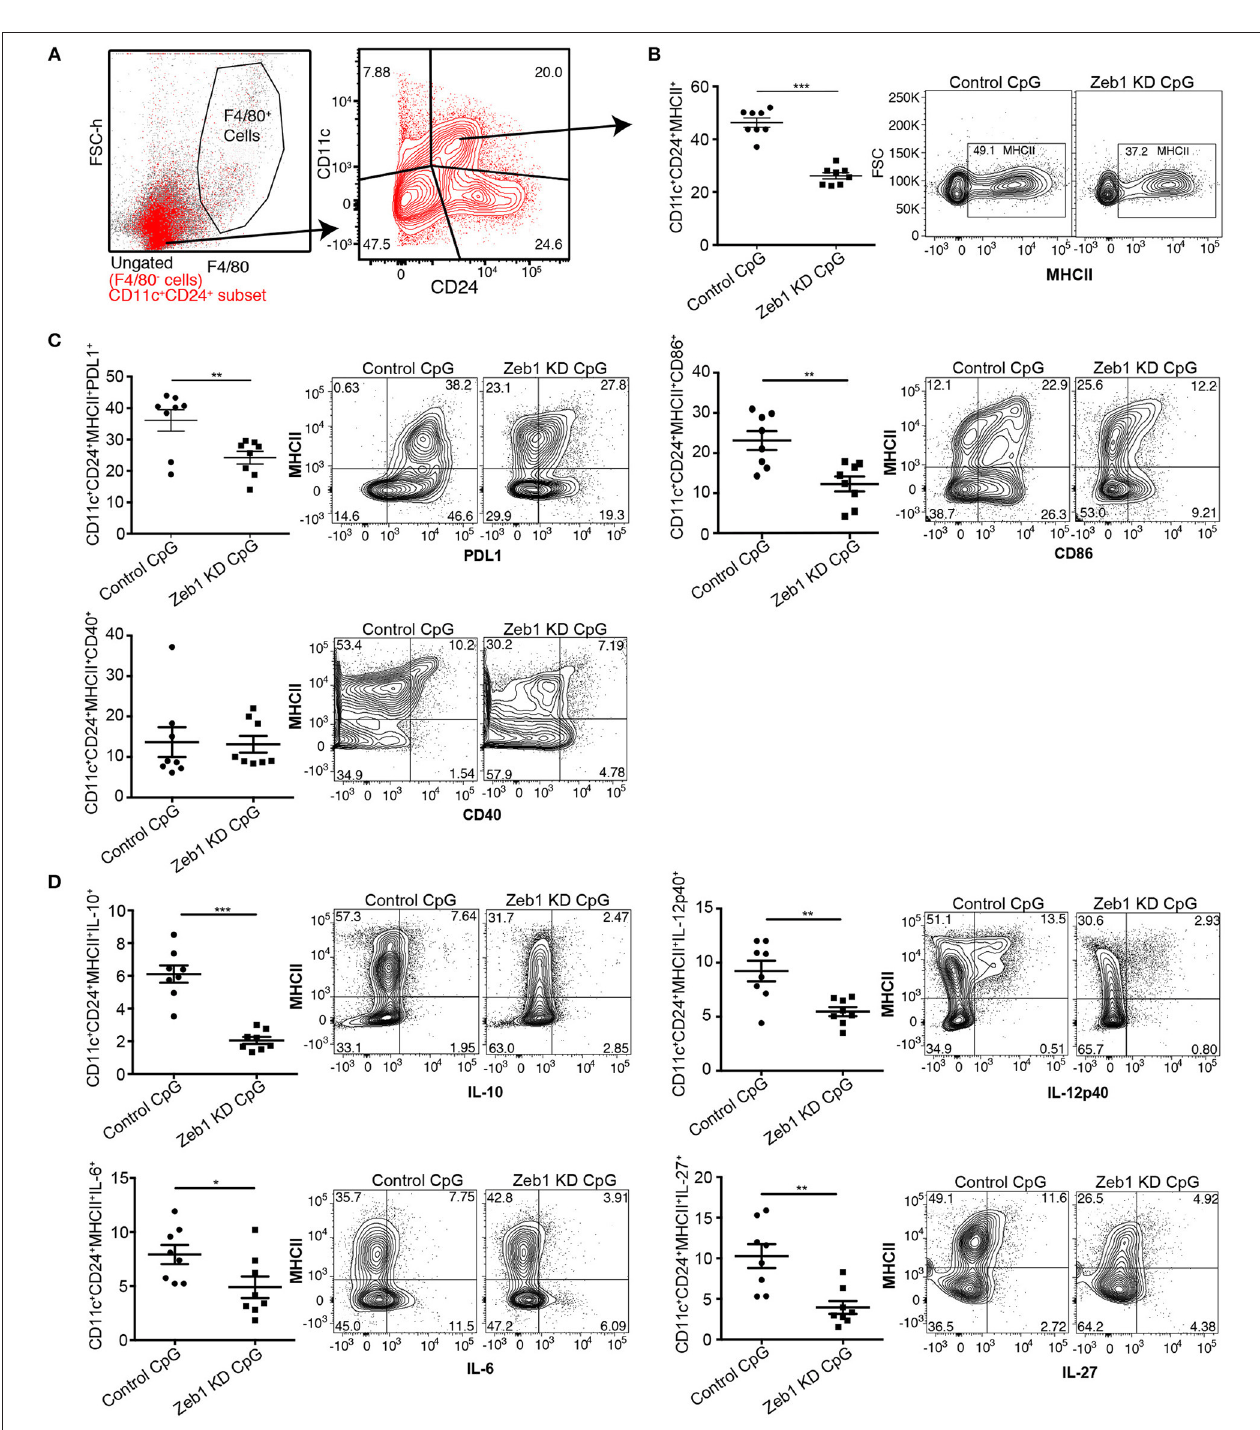
FIGURE 3 | Zeb1 depletion in bone-marrow derived primary cDC1 DCs showed decreased DC activation, co-stimulation and cytokine secretion n = 6–8. (A) FACS contour-plot showing the gating strategy used to remove F4/80 positive macrophage population from the CD11c + DCs to analyze the impact of Zeb1 KD on CD11c + CD24 + MHCII + DC population. High CD11c + CD24 + double positive DCs were considered as cDC1 DCs for analysis. (B) Scatter-plot and representative contour plots depicting the percentage of MHCII positive cells in F4/80 − CD11c + CD24 + gated BMDCs treated with control and Zeb1 shRNA3 followed by 12h CpG stimulation n = 6–8. (C) Scatter-plots and representative contour plots depicting the percentage positive cells for cell surface markers PDL1, CD86, and CD40 in F4/80 − CD11c + CD24 + gated BMDCs treated with control and Zeb1 shRNA3 followed by 12h CpG stimulation n = 6–8. (D) Scatter-plots showing the percentage positive cells for intracellular cytokines IL-10, IL-12p40, IL-6, and IL-27 in F4/80 − CD11c + CD24 + MHCII + gated BMDCs treated with control and Zeb1 shRNA3 followed by 12h CpG stimulation n = 6. p -values were calculated using two tailed unpaired student’s t -test, error bars represent SEM. * ≤ 0.05, ** ≤ 0.01, *** ≤ 0.001.